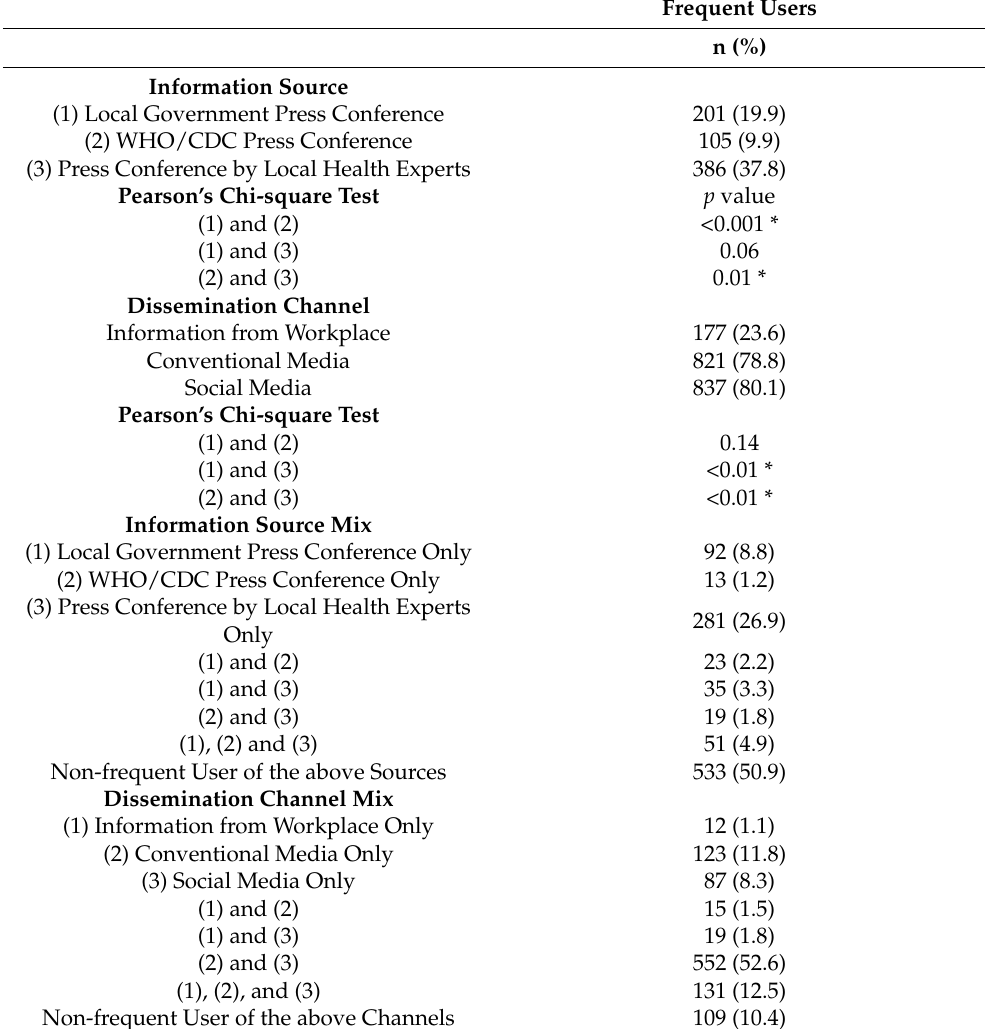
Table 3. Utilization of media sources (weighted with